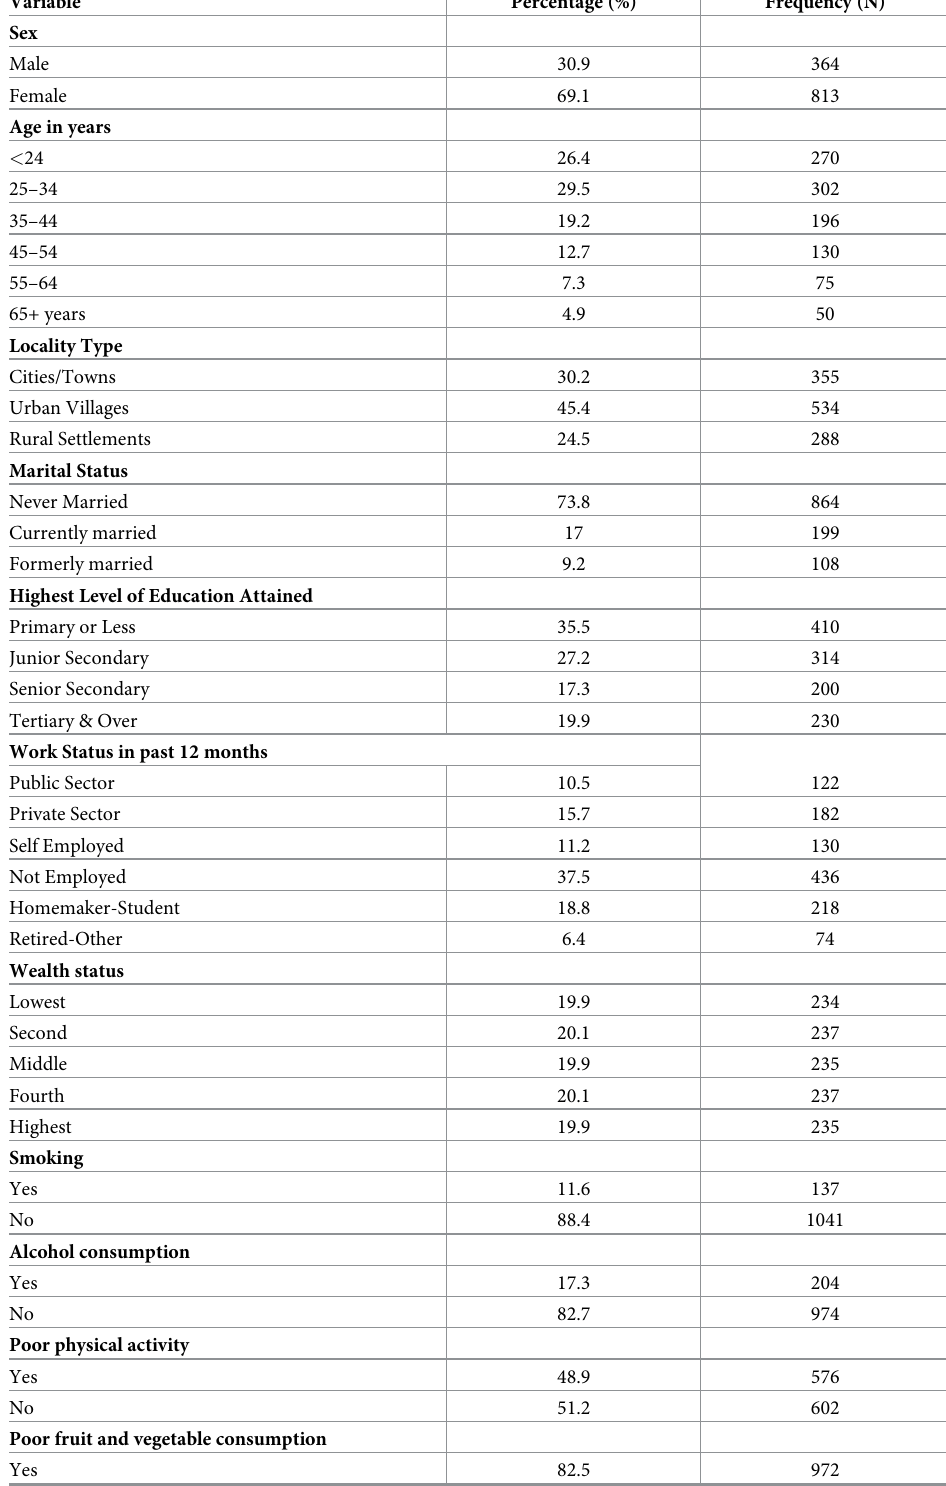
Table 1. Socioeconomic characteristics of the study population (N = 1178)-NCD survey,